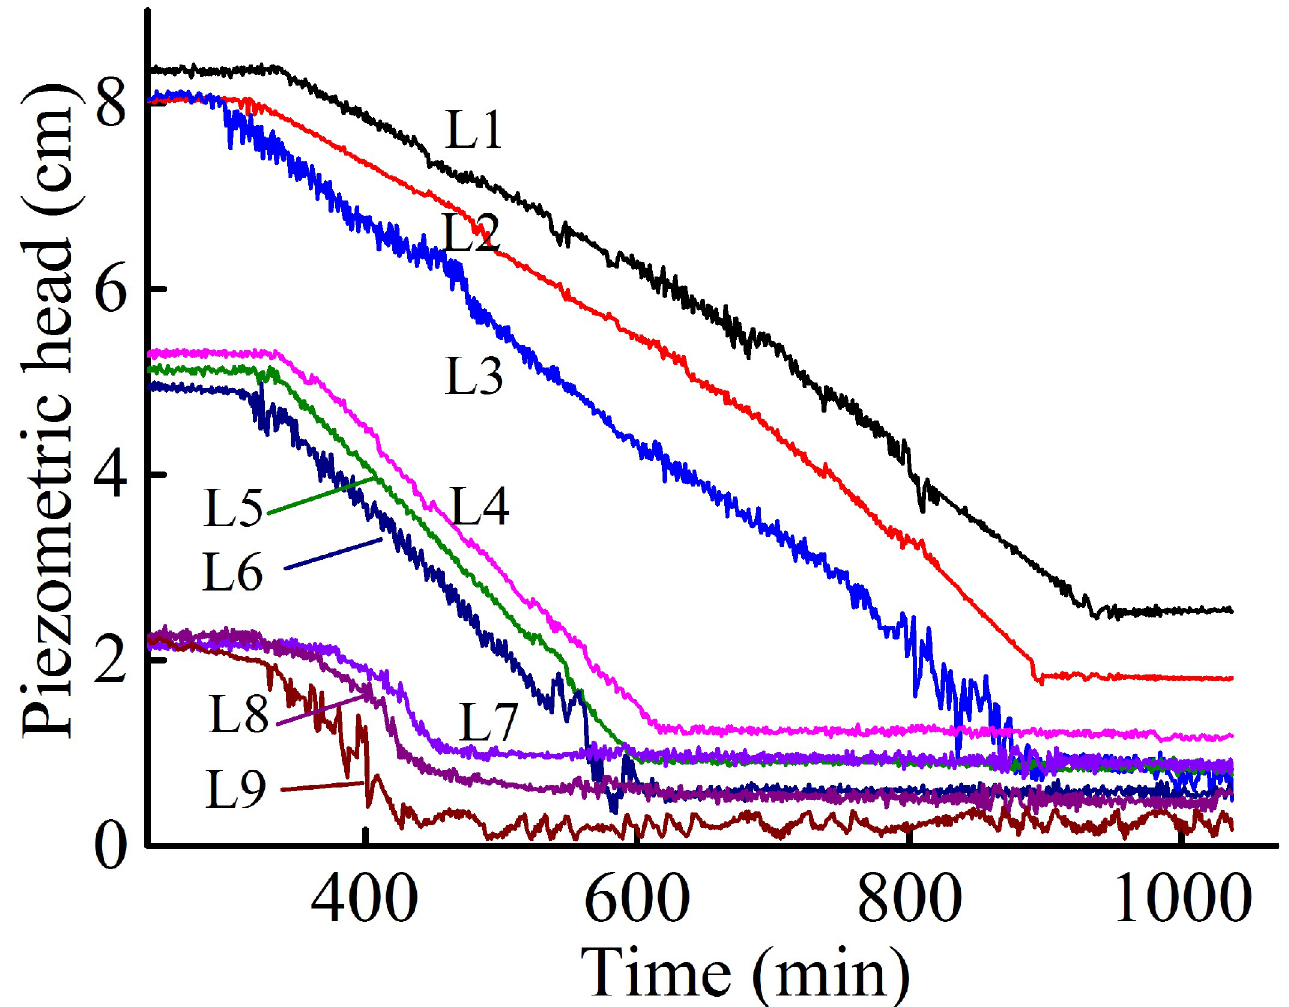
Fig 6. Variations in piezometric head during Soil C